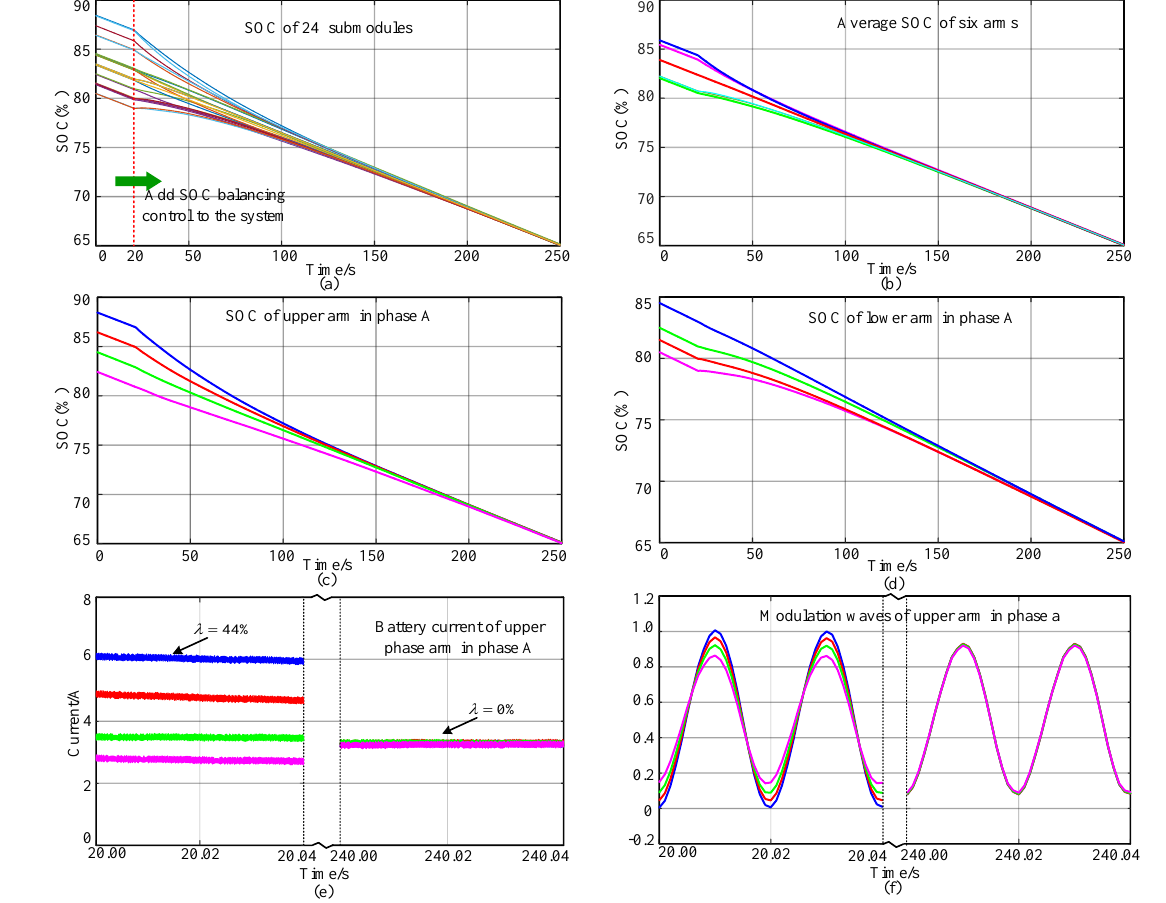
Figure 9. Simulation results of the modified SOC balancing control: ( a ) SOC of all submodules; ( b ) average SOC of all phase arms; ( c ) SOC of upper arm in phase a; ( d ) SOC of lower arm in phase a; ( e ) battery current of phase arm in phase A; ( f ) modulation waves of upper arm in phase A .